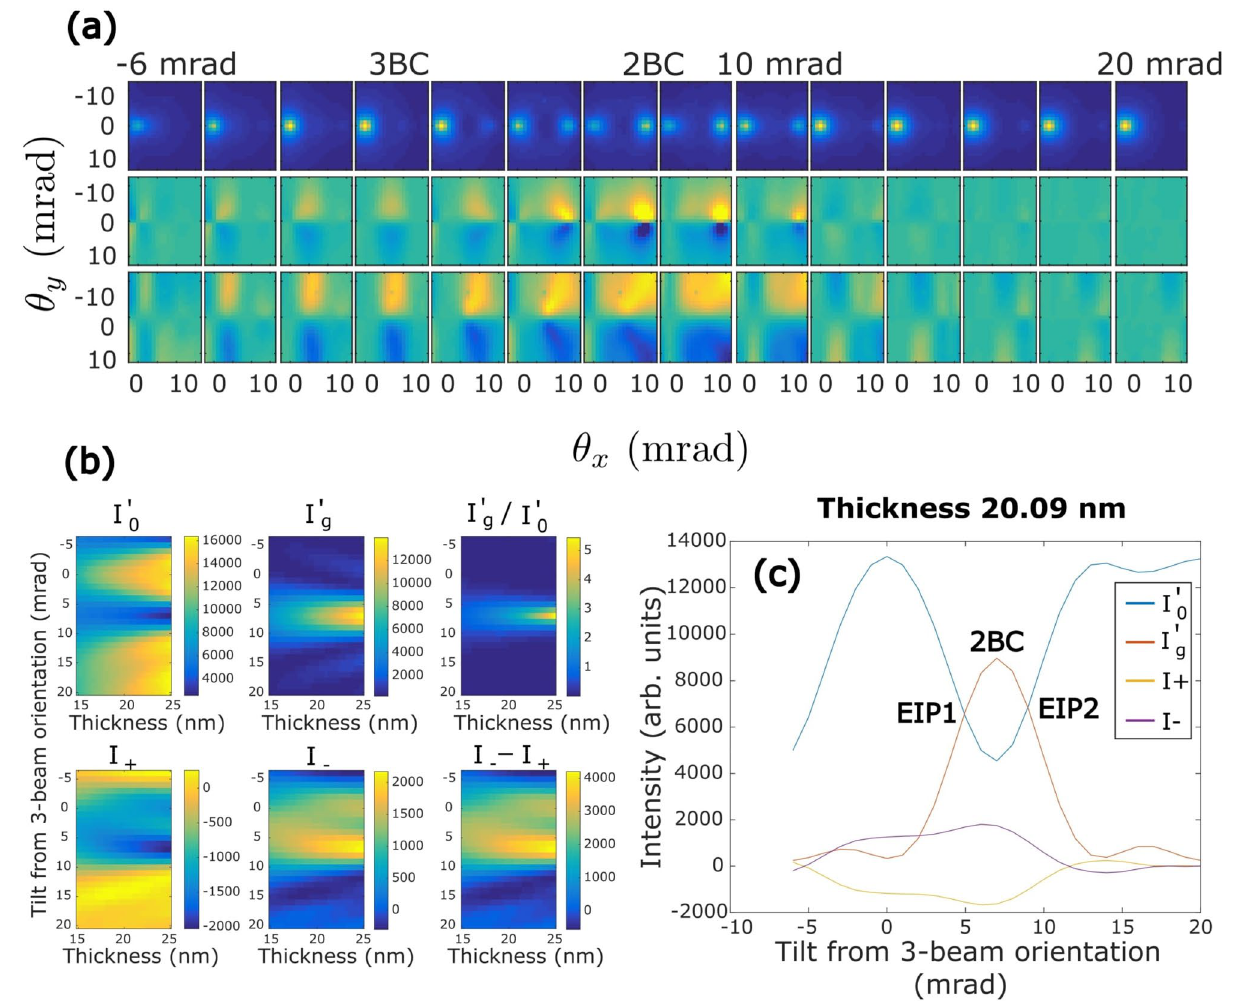
Figure 3. (a) Non-magnetic (top row), magnetic (EMCD; middle row) and relative magnetic (bottom row) diffraction patterns at Fe L 3 edge for calculated tilts from the three-beam orientation at sample thickness of 20 nm (b) inelastic intensities of 0 and g beam and their ratio as a function of sample thickness and tilt from 3BC (c) inelastic intensities of 0 and g beam and the magnetic signals plotted as a function of tilt from 3-beam